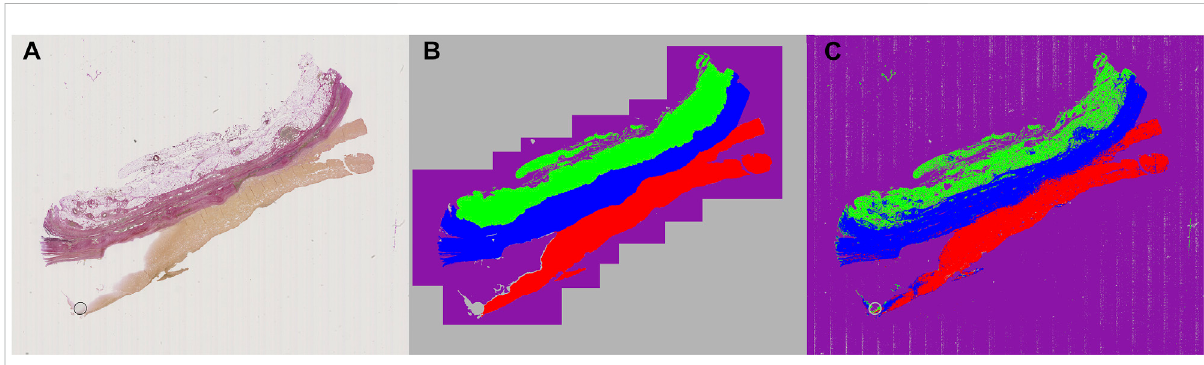
FIGURE 3 Example of raw, annotated and segmentation prediction image. (A) Input image, Weigert stained (B) Partially annotated ground truth. The gray area surrounding the purple region is removed from the dataset during training to reduce class imbalance and improve training time (C) Segmentation prediction output from the neural model. Color coding: Blue: Zone 1. Green: Zone 2. Red: Thrombus. Purple: Background. Gray: